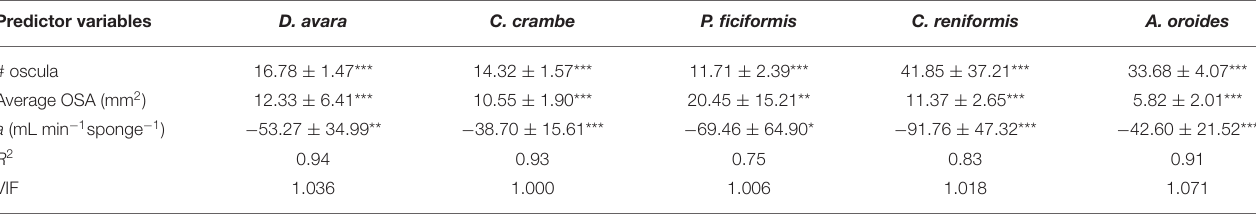
TABLE 2 | Multiple regression analysis to predict the sponge pumping rate (PR, mL min − 1 sponge − 1 ) based on number of oscula (# oscula) and the average osculum cross-sectional area (average OSA, mm 2 ) within each of the five Mediterranean sponge species. Predictor